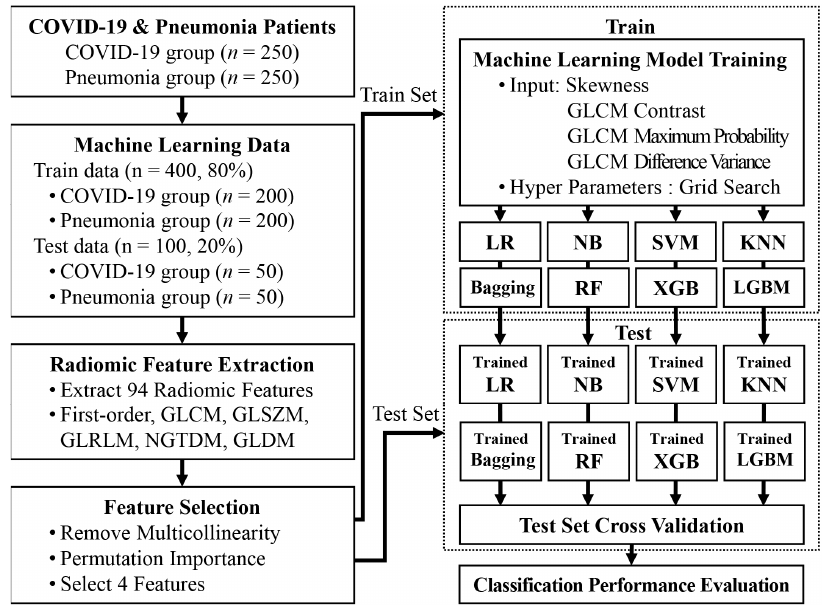
Figure 1. Flowchart showing the data and machine learning process used to differentiate between COVID-19 and pneumonia using chest X-ray images. GLCM, gray level co-occurrence matrix; GLSZM, gray level size zone matrix; GLRLM, gray level run length matrix; NGTDM, neighboring gray-tone difference matrix; GLDM, gray level dependence matrix; LR, logistic regression; NB, naive Bayes; SVM, support vector machine; KNN, k-nearest neighbor; RF, random forest; XGB, extreme gradient boosting; LGBM, light gradient boosting machine.